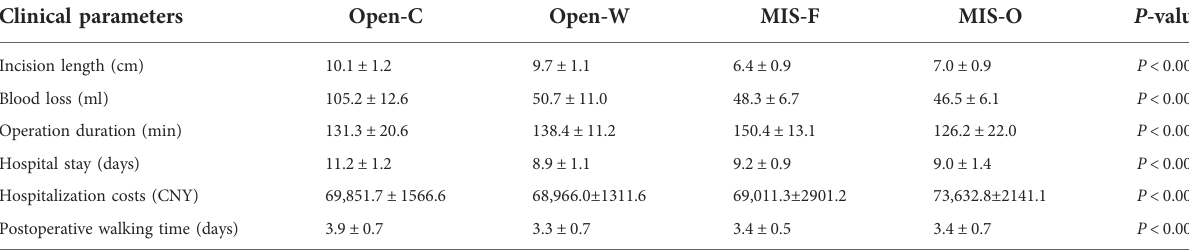
TABLE 2 Clinical outcomes of the four groups. Clinical